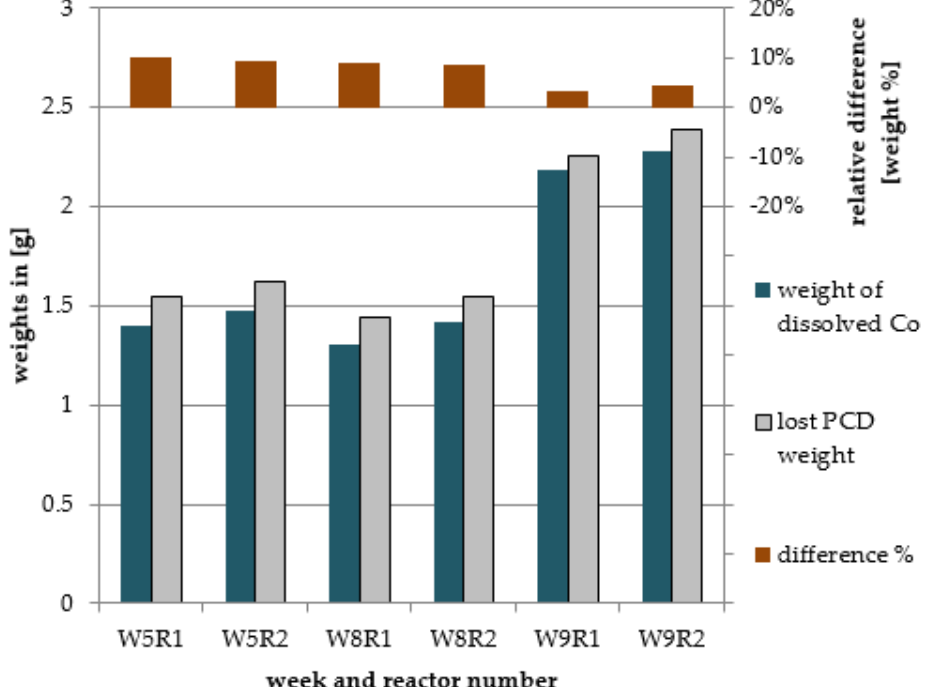
Figure 12. Weight of dissolved Co (II) versus lost PCD weight.